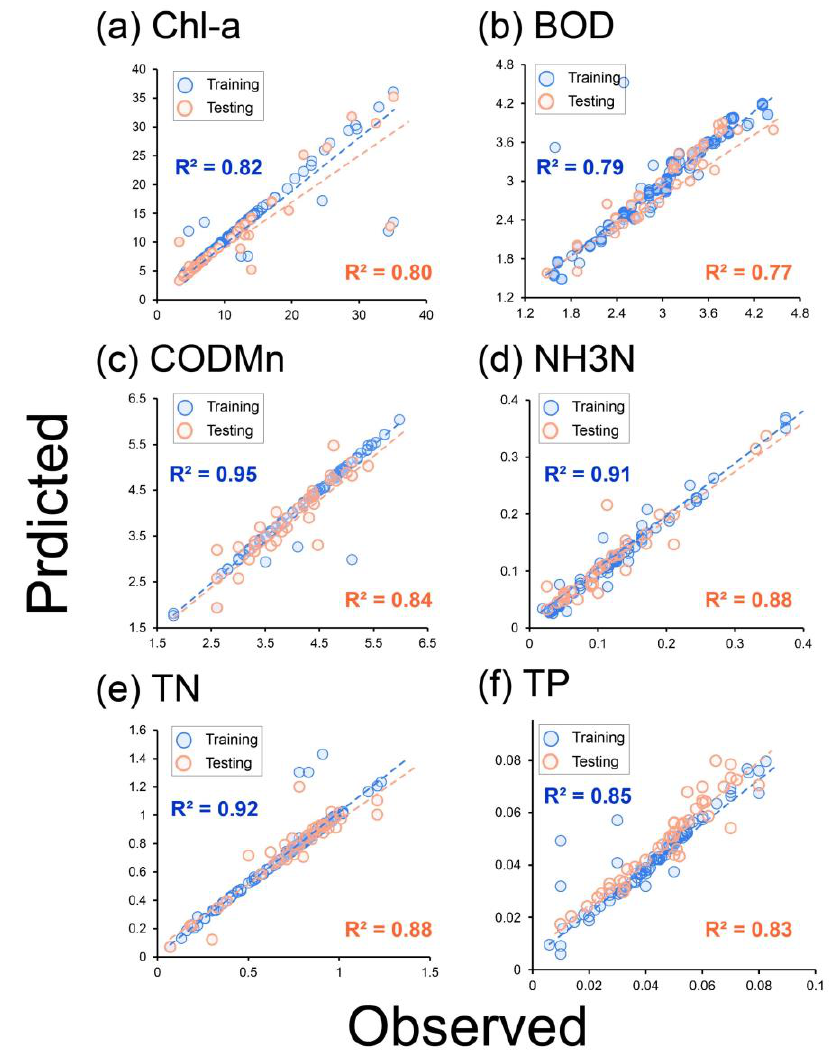
Figure 4. Plots of the observed versus retrieved water quality concentrations when applying the ConvLSTM methodology to the training and testing datasets: ( a ) Chl in mg/m 3 ; ( b ) BOD in mg/L; ( c ) CODMn in mg/L; ( d ) NH3-N in mg/L; ( e ) TN in mg/L and ( f ) TP in mg/L. ( c ) CODMn in mg/L; ( d ) NH3-N in mg/L; ( e ) TN in mg/L and ( f ) TP in